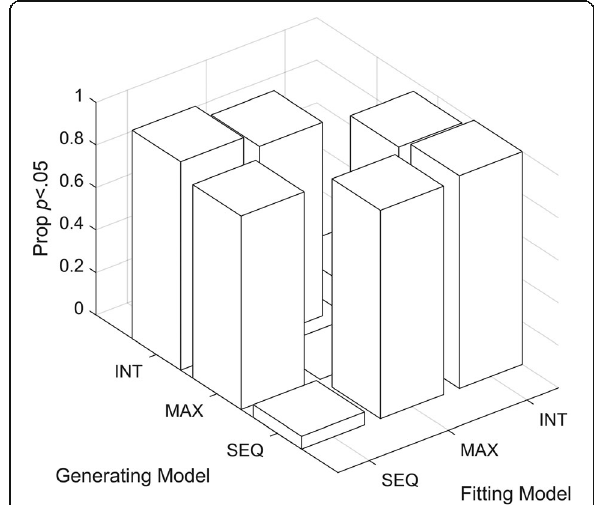
Fig. 3 Proportion of p < .05 for models cross fit to simulated data. Each model was fit to its own 100 simulated datasets and cross fit to the 100 datasets generated by the other models. The bars show the proportion of datasets for which the models could be rejected at α =